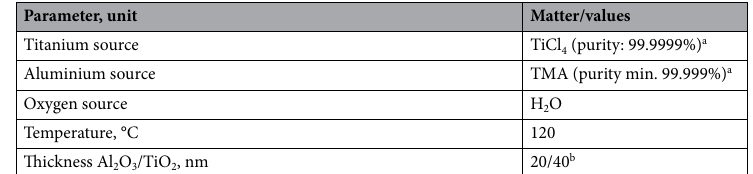
Table 2. Conditions of deposition of ALD Al 2 O 3 + TiO 2 layers. a Precursor of Strem Chemicals, Inc. b Thickness was determined by spectroscopic ellipsometry on reference coatings applied to silicon wafer substrates.